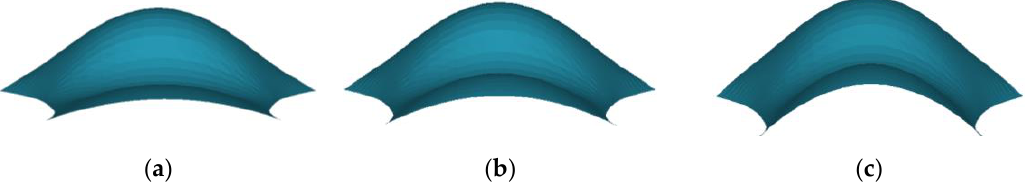
Figure 13. Shape variation of Model 2 during the optimization process: ( a ) Initial guess; ( b ) 100th step; and, ( c ) 1000th step (optimal).